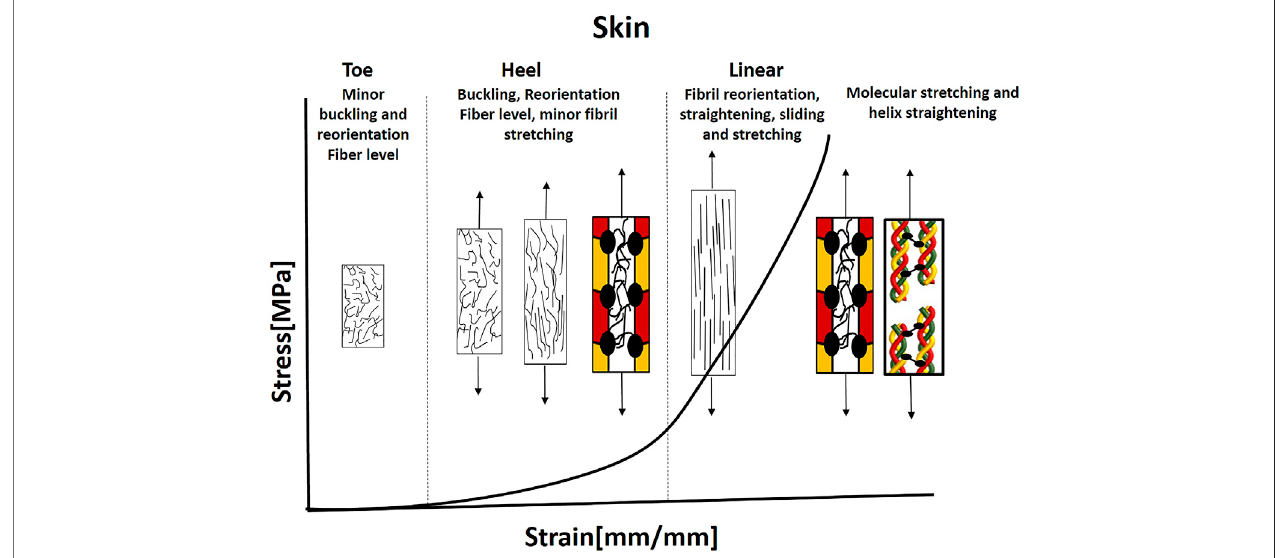
FIGURE 9 | Illustration of the J-shaped behavior and mechanical mechanisms under tension in the skin. The collagen fi bers are noncontinuous with bimodal orientation and distribution of orientations. In the toe and regions, buckling and bending of the fi bers occur together with minor Fiber recruitment and straightening (Bancelinetal.,2015;Lynchetal.,2017).Mostrecruitmentandstraighteningoccursinthelinearregionuptocriticalloadwhen fi brilslidingandstretchingstart,usingthe